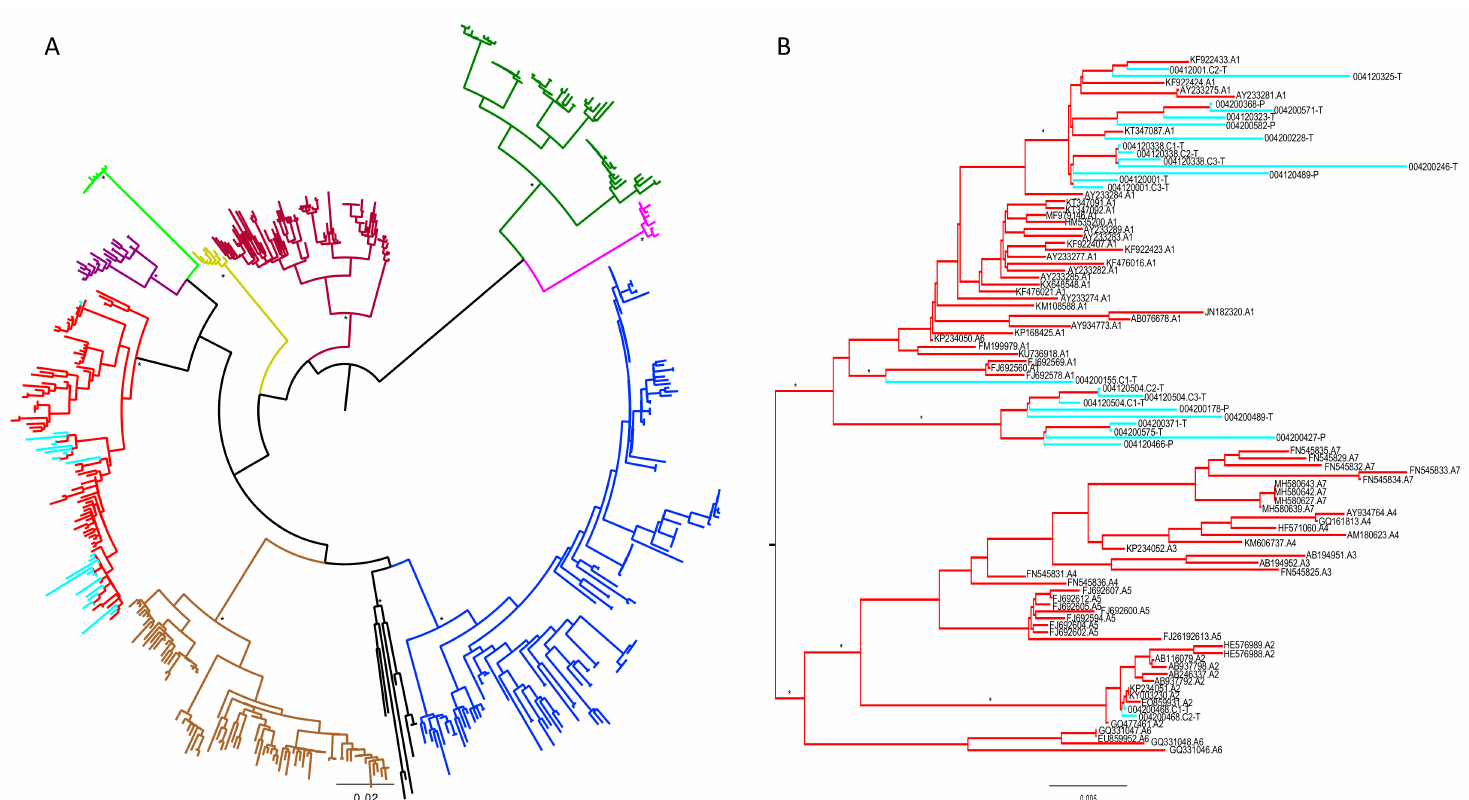
Figure 1. Maximum likelihood tree (midpoint rooted) showing the phylogenetic clustering between South African HBV genome sequences and randomly chosen reference sequences (A–J). The phylogenetic tree was constructed from the codon alignment using RaXML v 8.2 with the General Time Reversible model of nucleotide substitution (GTR + G) and 1000 bootstrap replicates. Tree ( A ) shows all HBV sequences from this study including reference strains, while tree ( B ) shows only clustering between HBV sequences from this study and HBV subtype A reference. Bootstrap support values above 70% are shown with an asterisk (*). HBV sequences from this study are highlighted in light blue, while subtype A references are red. Brown = subtype B reference, blue = subtype C reference, maroon = subtype D reference, yellow = subtype E, dark green = subtype F reference, lumo green = subtype G reference, pink = subtype H reference, purple = subtype I reference, black = subtype J